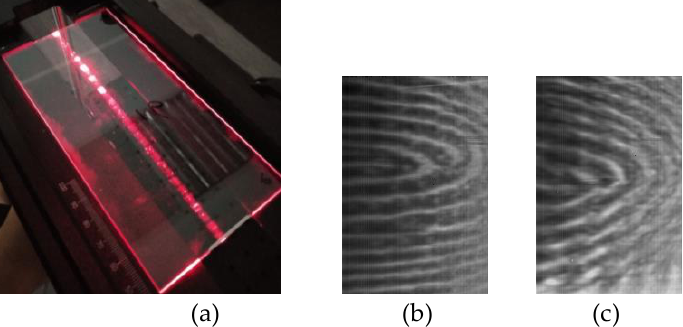
Figure 9. (a) Cross-sectional view of reflection surface 2 of the cover glass. (B) Using UA3P Figure 9. ( a ) Cross-sectional view of reflection surface 2 of the cover glass. ( b ) Using UA3P measurement measurement results, the angle of reflection surface 2 is 39.09 degrees. results, the angle of reflection surface 2 is 39.09 degrees.